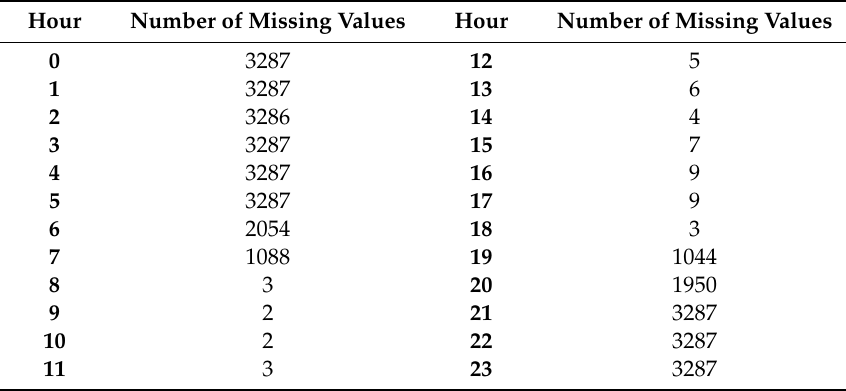
Table 7. Missing values for solar